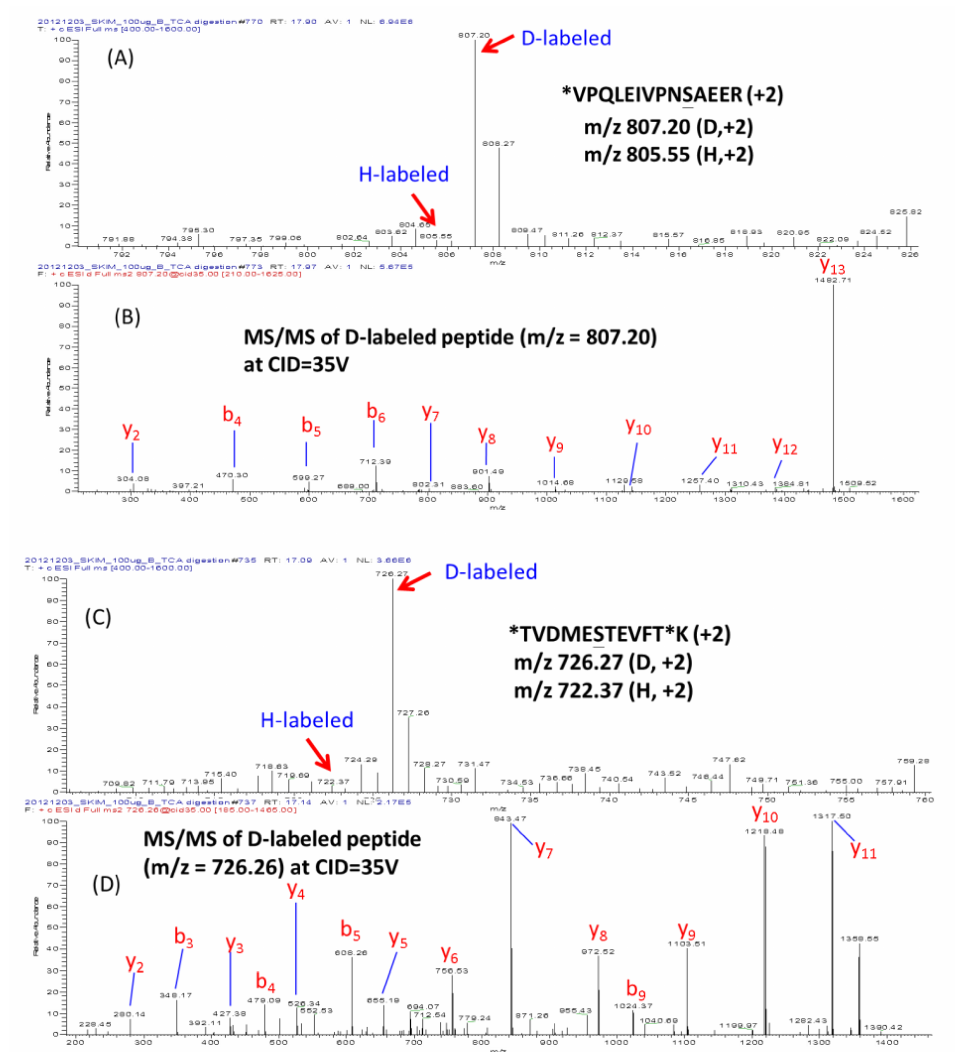
Figure 3. Determination of phosphorylation degrees at Ser130 of α -S1-casein and Ser158 of α -S2-casein. ( A ) LC-MS (LTQ Orbitrap) spectrum of H- and D-labeled *VPQLEIVPNSAEER, which contains Ser130 of α -S1-casein; ( B ) MS / MS spectrum of D-labeled *VPQLEIVPNSAEER; ( C ) LC-MS spectrum of H- and D-labeled *TVDMESTEVFT*K (Ser158 of α -S2-casein); and ( D ) MS / MS spectrum of D-labeled *TVDMESTEVFT*K. “*” marks the dimethyl labeling site; and “_” indicates the original phosphorylation